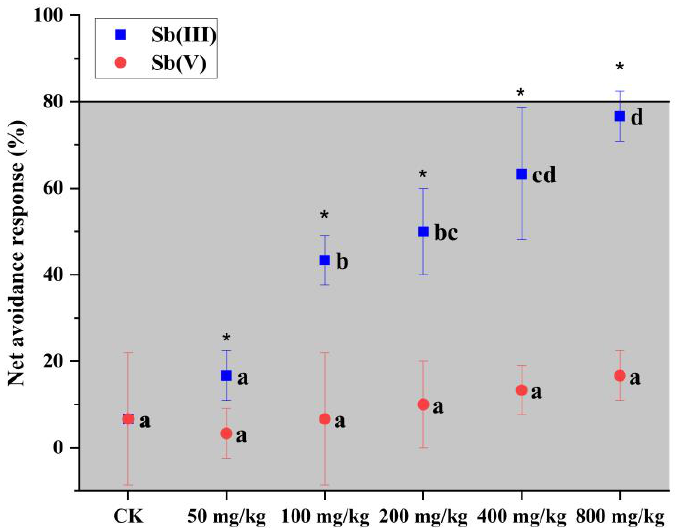
Figure 2. Net avoidance test using earthworm E. fetida exposed to Sb (III) and Sb (V) treatment. NAR > 80% indicate a possible loss in habitat function. Data were reported as mean ± standard deviation (M ± SD, n = 3). Significant differences in the same treatment were marked with dif- ferent lowercase letters at p < 0.05. Significant differences between Sb (III) and Sb (V) of the same concentration level were marked with an asterisk at p < 0.05.